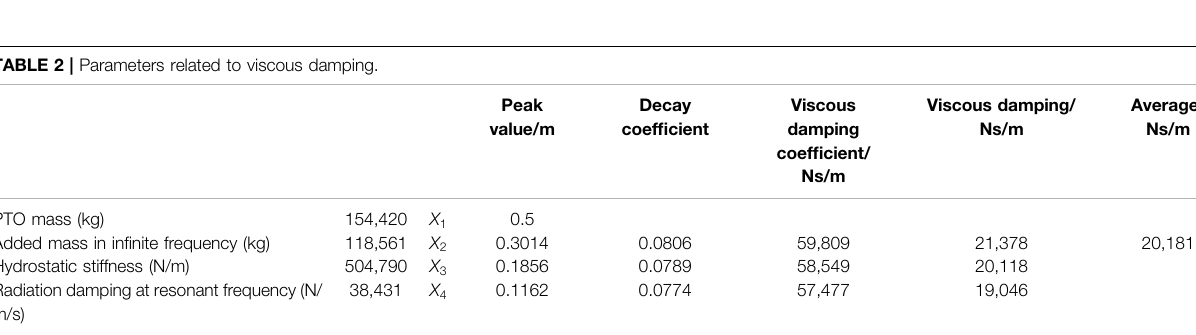
TABLE 2 | Parameters related to viscous